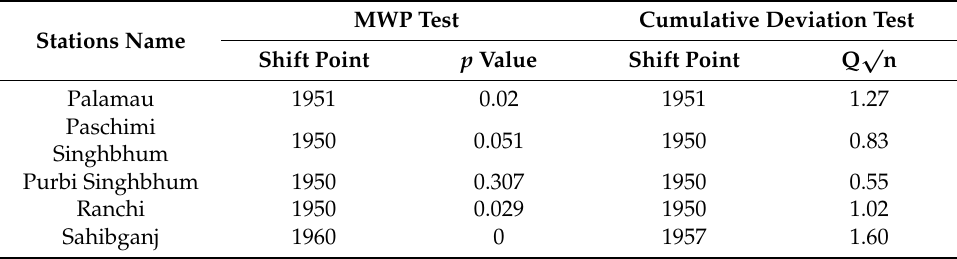
Figure 5. Spatial distribution of Sen’s slope value and trend direction (Mann Kendall statistics) from 1901–1951of ( a ) Annual; ( b ) Monsoon; ( c ) Pre-monsoon; ( d ) Post-monsoon and ( e ) Winter season.